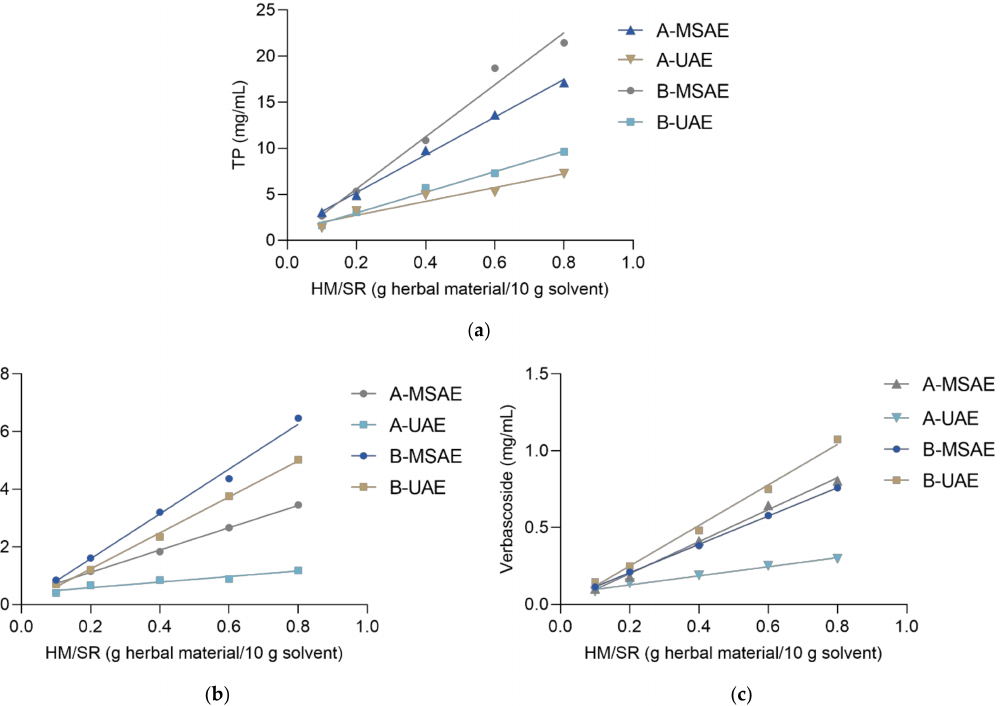
Figure 2. The relationship between the HM/SR (herbal material/solvent ratio) and the concentration of ( a ) TP, ( b ) oleuropein, and ( c ) verbascoside in the extracts. A, B denote the extraction solvent; UAE, MSAE denote the extraction technique.